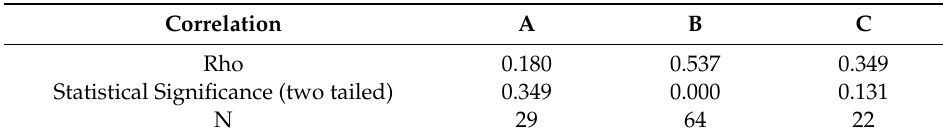
Table 3. The estimated Spearman Rho coe ffi cients between variables of question 11 (total light) and question 12 (daylight) across the three